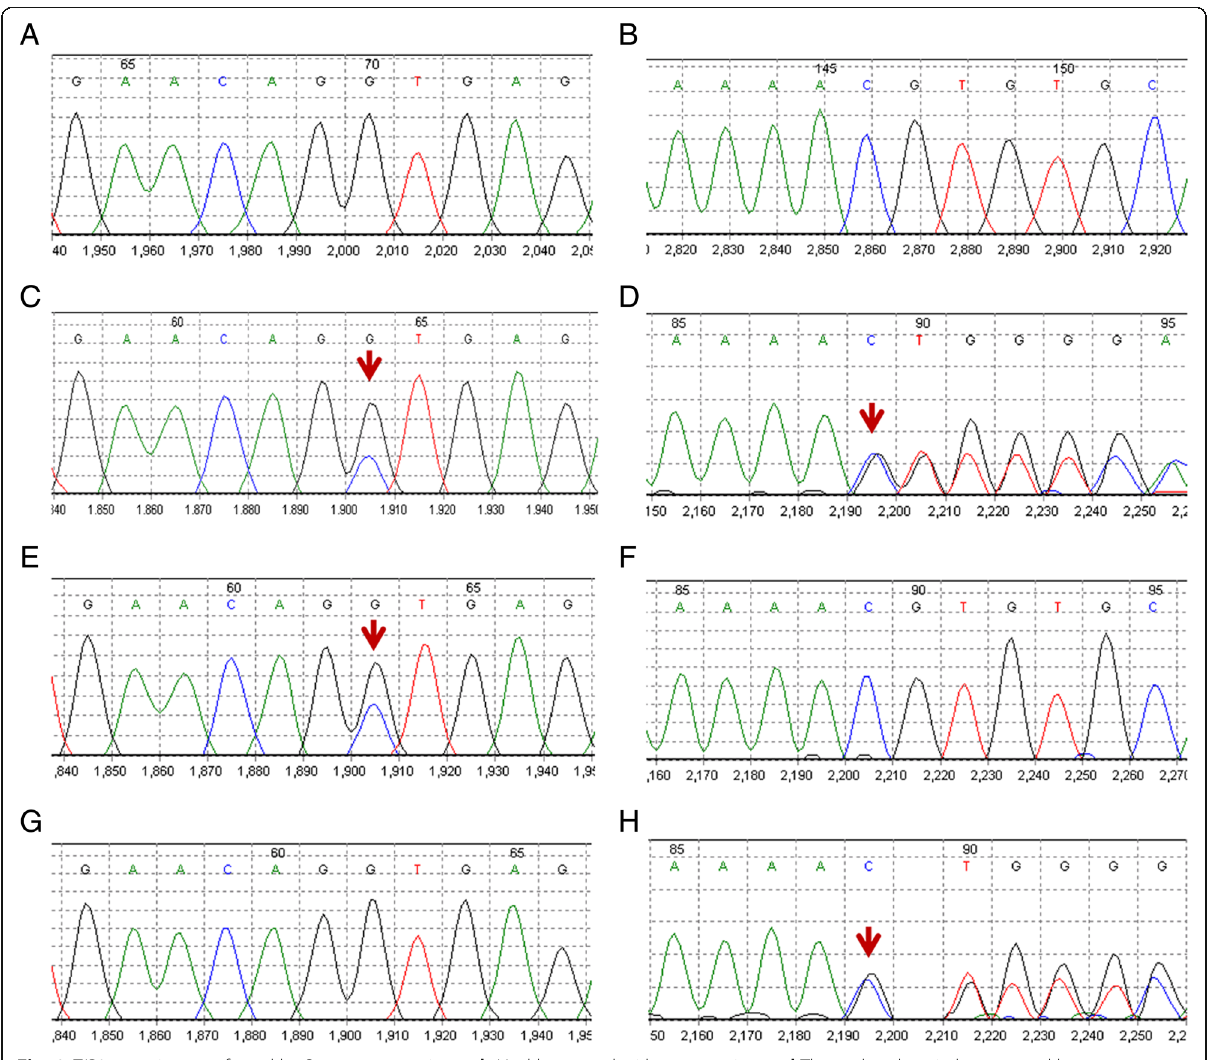
Fig. 2 TJP2 mutations confirmed by Sanger sequencing. a , b Healthy control without mutation. c , d The proband carried compound heterozygous mutations c.2448+1G>C/c.2639delC (p.T880Sfs*12) of TJP2 . e , f The mother carried c.2448+1G>C mutation of TJP-2 ( e ). g , h The father carried c.2639delC (p.T880Sfs*12) mutation of TJP-2 ( h